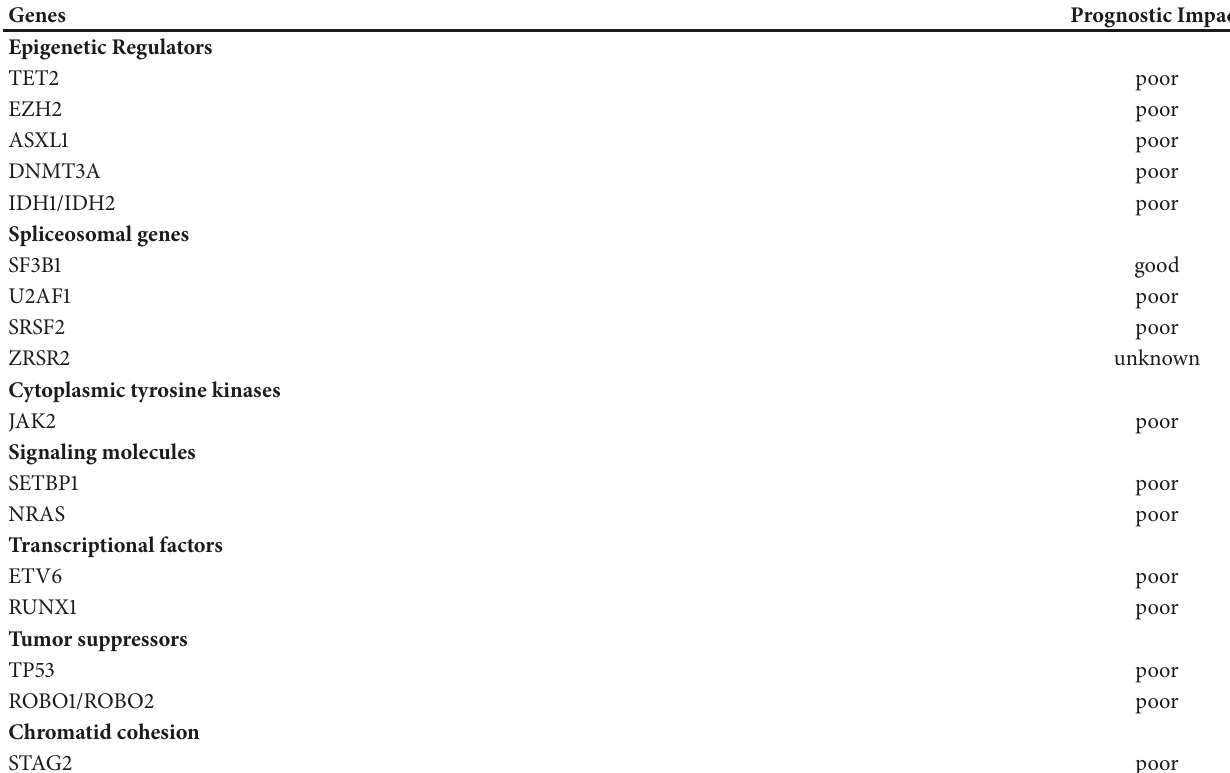
Table 1: Common gene mutations in MDS and the prognostic values